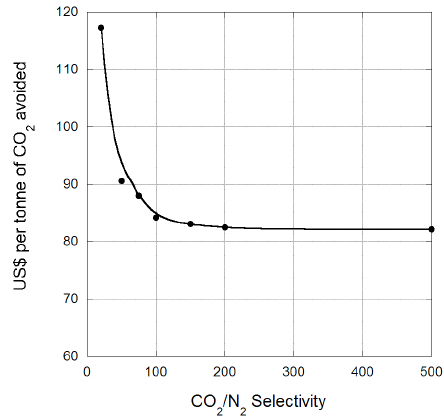
Figure 4. Cost of capture (US$ per tonne of CO 2 avoided) for NGCC as a function of membrane CO 2 /N 2 selectivity.